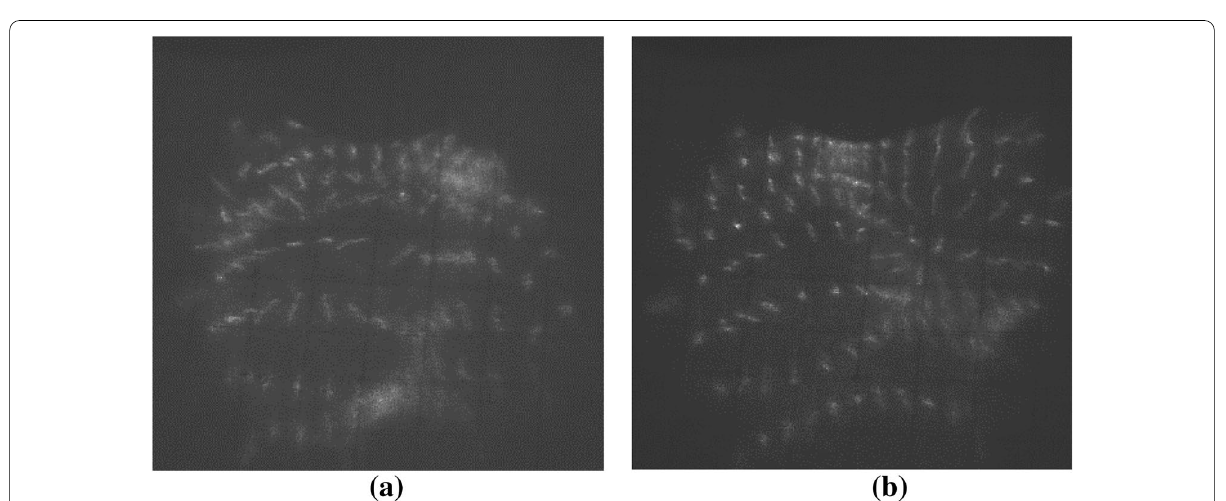
Figure 11 Experiment results of (2, 1)